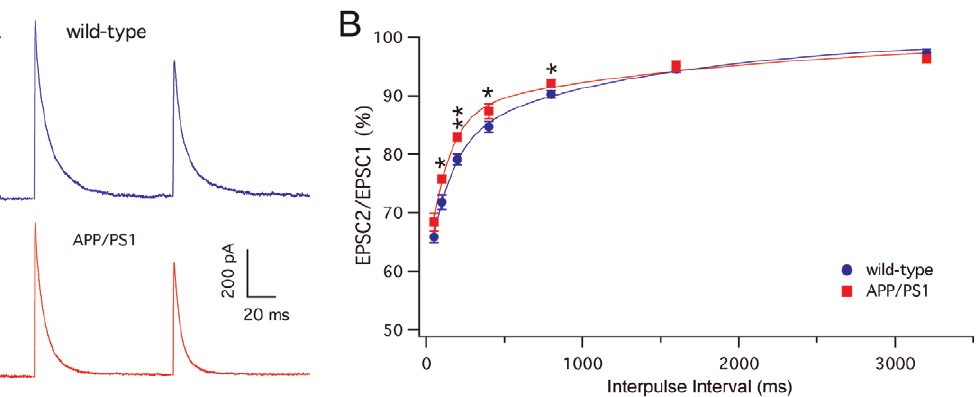
Figure 8. CF-EPSCs in wild-type and APP/PS1 PCs. ( A ) Representative traces of postsynaptic currents evoked by climbing fiber paired-pulse stimulation with an interpulse interval of 100 ms in wild-type (blue) and APP/PS1 (red) mice. ( B ) Time course of paired-pulse depression of CF-EPSC in wild-type (blue circles, n=12) and APP/PSl mice (red squares, n=10). The lines are double exponentials fittings of wild-type and APP/PS1 data points. The paired-pulse depression is expressed as the percentage of the amplitude of the second EPSC relative the first one (mean 6 SEM) and is plotted as